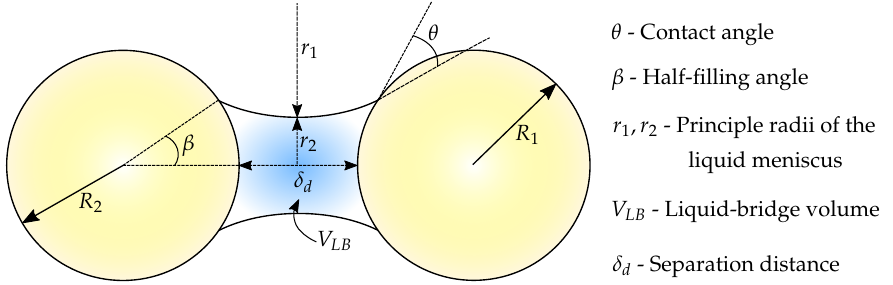
Figure 6. A schematic representation of the liquid-bridge contact